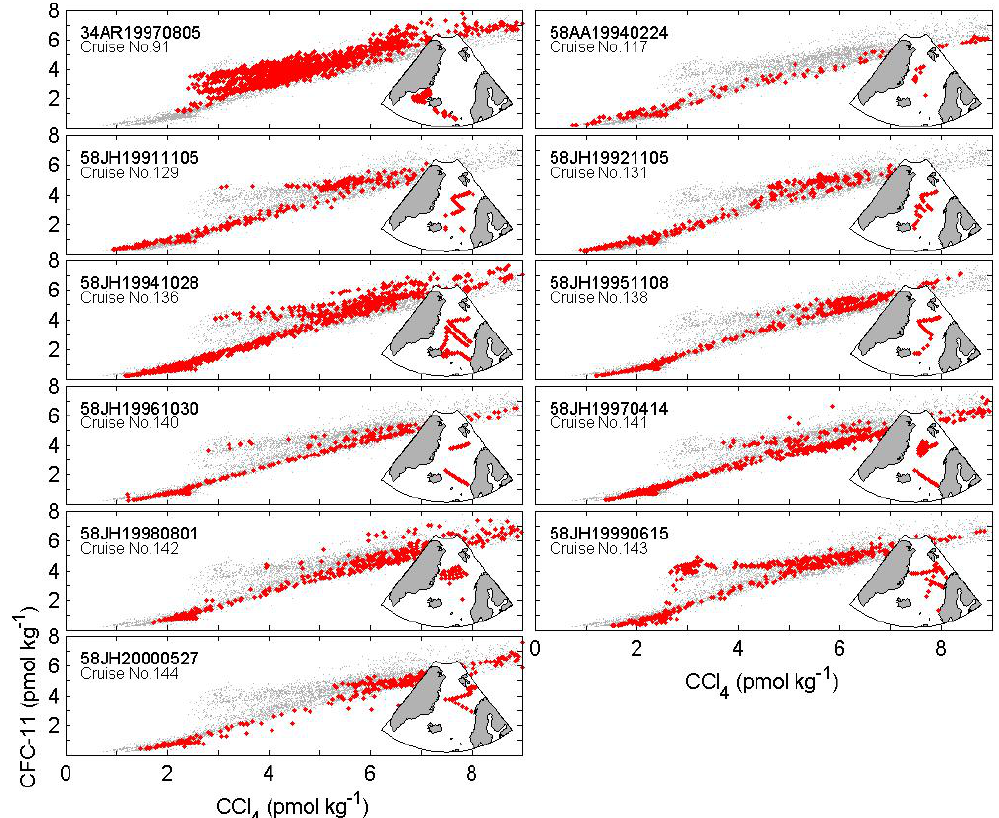
Figure 8. CFC-11 vs. CCl 4 . See Fig. 2 for